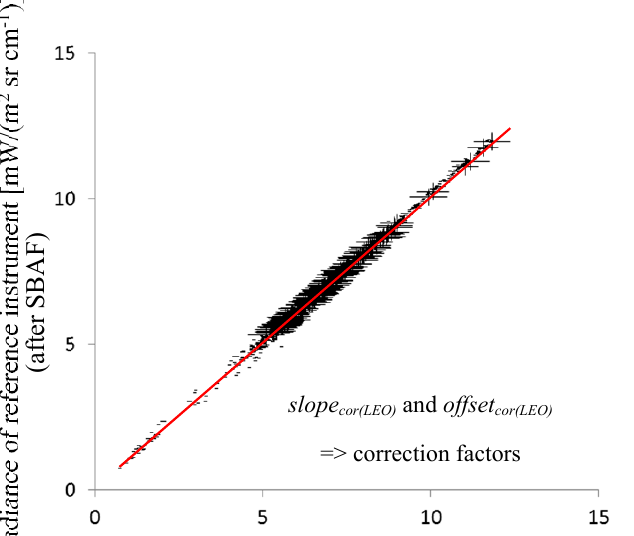
Figure 7. Conceptual diagram to get calibration coefficients ( slope cor(LEO) and offset cor(LEO) ). These are derived from the linear regression between radiances from the reference and monitored instrument. The x and y values of each plot are the averages of monitored and reference radiances in the FovBox .